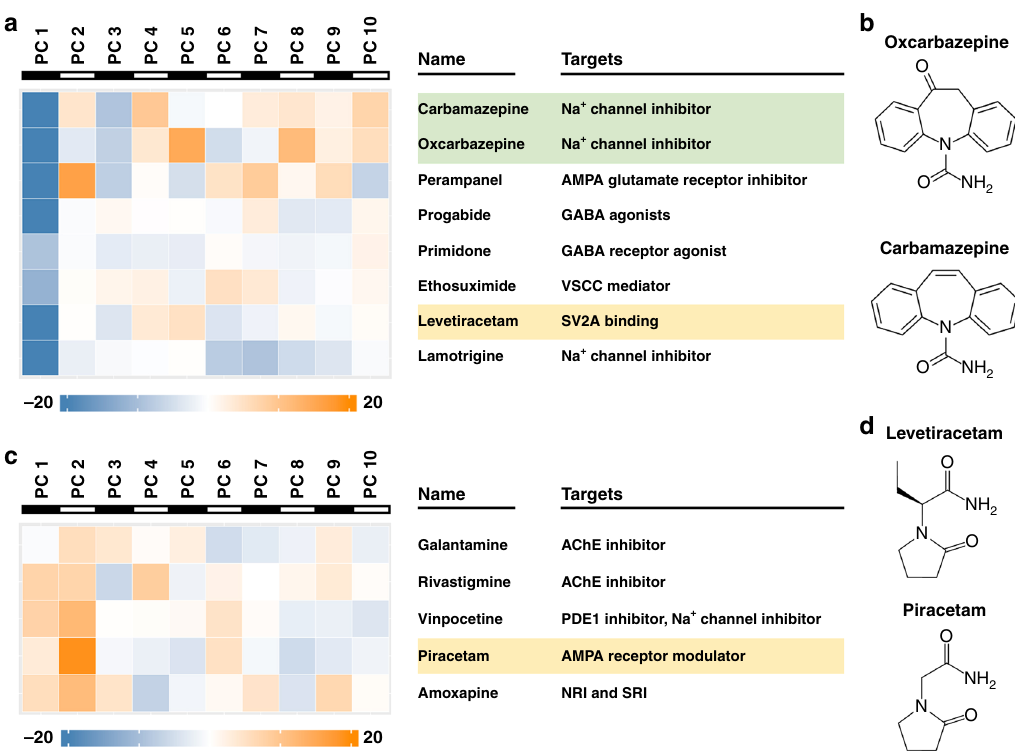
Fig. 4 Functional classi fi cation of CNS drugs with diverse mechanisms of actions. a Molecular targets of the drugs in the signature subgroup of BAM cluster 4 (associated with N03:Antiepileptics ATC category). b Similar chemical structures of carbamazepine and oxcarbazepine, green shaded in ( a ), two known antiepileptic drugs. c Molecular targets of the drugs in the signature subgroup of BAM cluster 8 (associated with N04:Anti-Parkinson ATC category). d Chemical structures of levetiracetam (N03:Antiepileptics) and Piracetam (N06:Psychoanaleptics), yellow shaded in ( a ) and ( c ), which are in distinct ATC categories and fi nd largely different clinical uses despite their structural similarity. Ten principal components (PCs) were listed in panels ( a ) and ( c